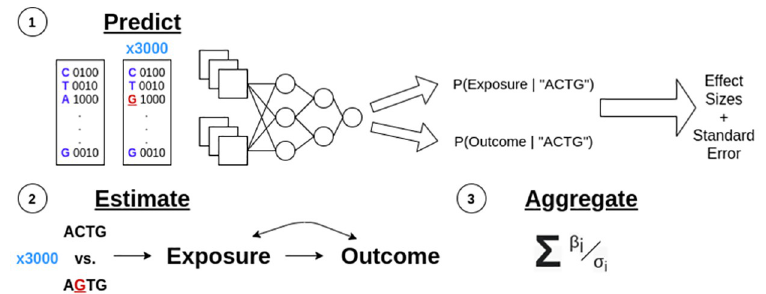
Fig 1. Graphical representation of DeepMR ’s high-level steps. DeepMR combines in silico mutagenesis and Mendelian randomization (see Algorithm overview). Predict corresponds to steps 1 through 4. Estimate corresponds to step 5. Aggregate corresponds to step